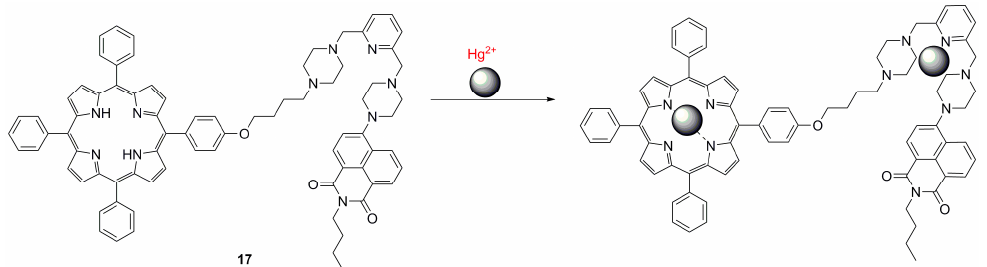
Figure 5. Schematic of phthalocyanine − porphyrin heterodyads for the detection of Pb 2+ ion by fluorescence resonance energy transfer (FRET). Reproduced from ref [38,40,41].